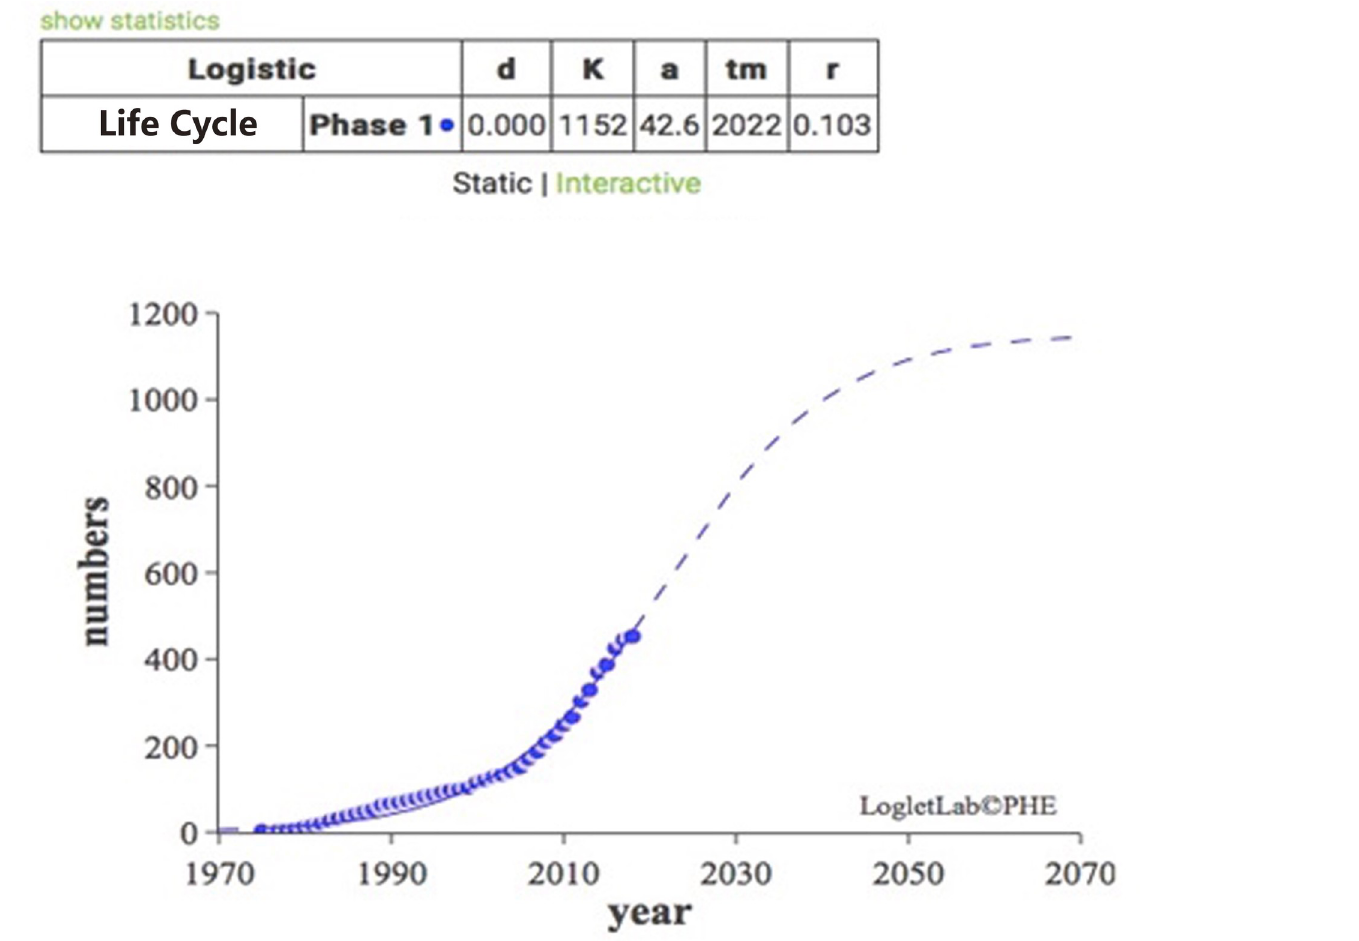
Fig 8. Technology development life cycle fit